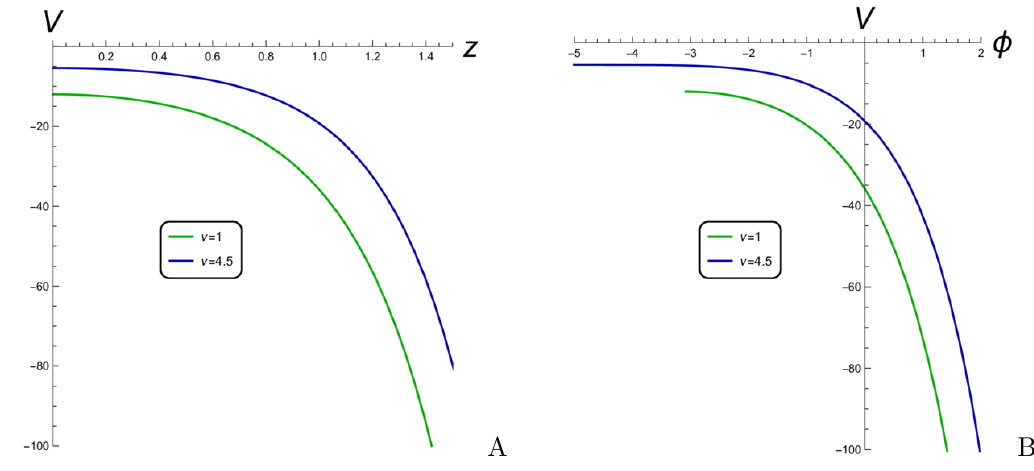
Figure 45 . Dilaton potentials that support vacuum solutions corresponding to isotropic and anisotropic cases (cid:23) = 4 : 5 with c = (cid:0) 1 and initial conditions (cid:30) (1) = 0 as function of z A) and (cid:30)